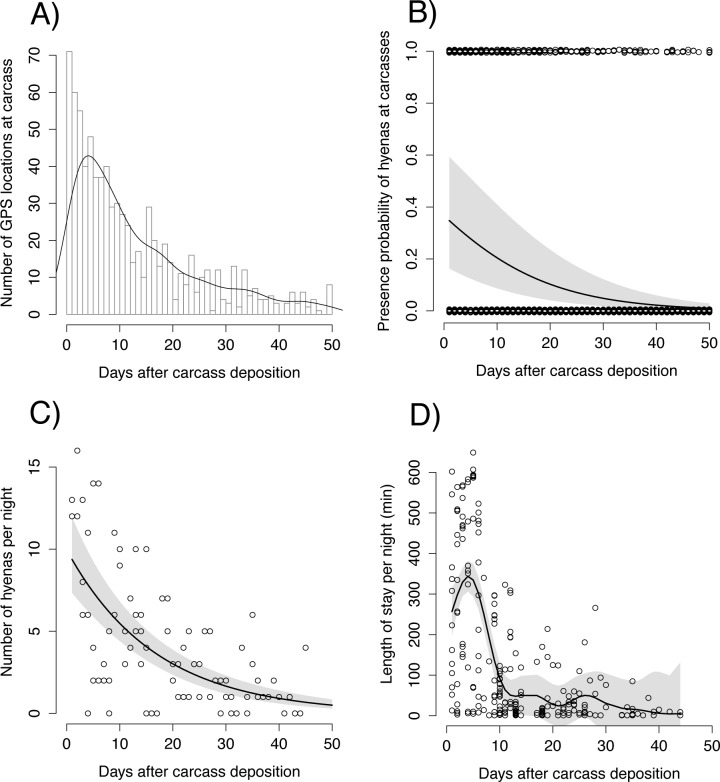
Use of elephant carcasses by spotted hyenas as a function of time after carcass deposition inferred by means of GPS data (A and B) and camera trapping (C and D).Histogram of the number of GPS locations from all radio-collared hyenas (A) and likelihood of finding hyenas (B) within a radius of 500 m from elephant carcasses (n = 24). In A, the line represents the density estimates. In C, data from all five carcasses monitored with camera traps were used. In D, data from the two carcasses where each single individual hyena present had been identified were used (see text form more details). Grey shaded areas represent confidence intervals. Dots represent raw data. Jittering has been introduced in B for easier visualization.